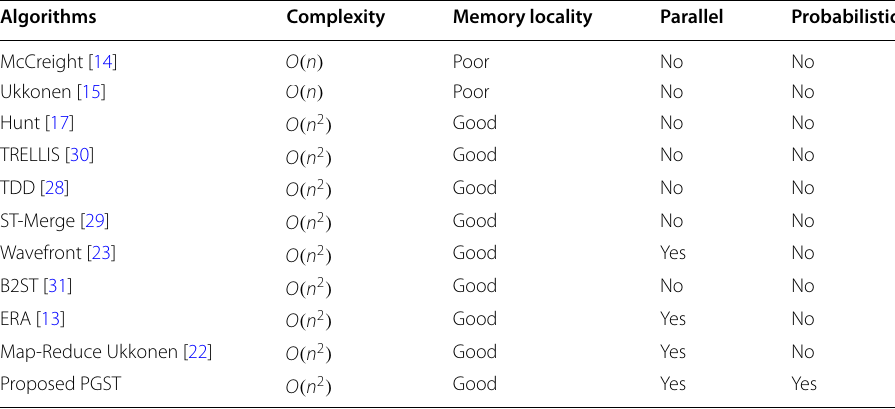
Table 1 Comparison of the most important algorithms for suffix tree construction Algorithms